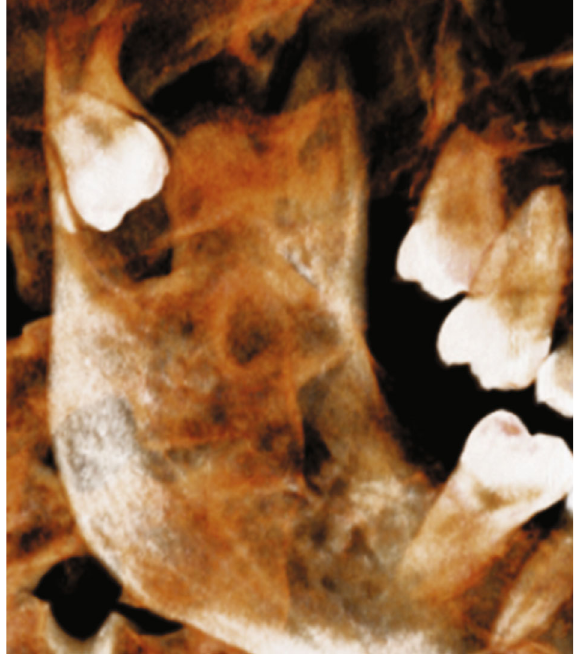
Figure 12: 3D reconstructed view.